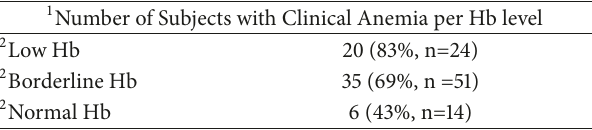
Table 1: Hemoglobin levels and clinical